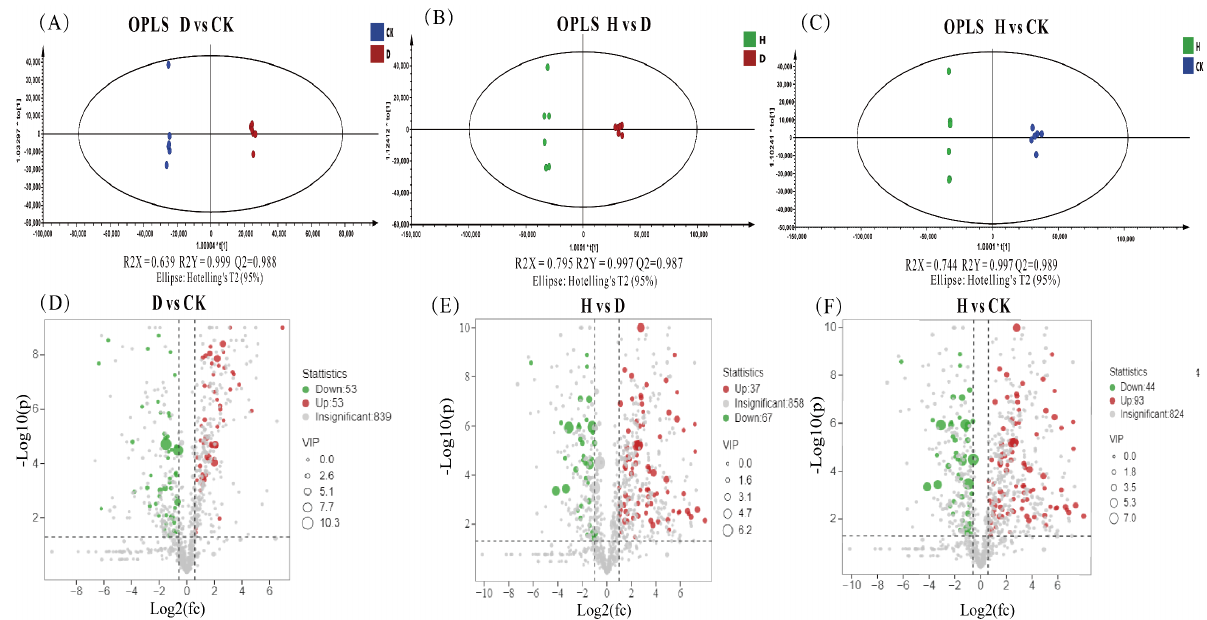
Figure 5. OPLS-DA score plots ( A – C ) and volcano plots ( D – F ) in response to different treatments: H: P852 of 10 µ g/mL, D: 1 µ g/mL of P852, and CK: sterile water to treat Fusarium wilt of Faba bean.